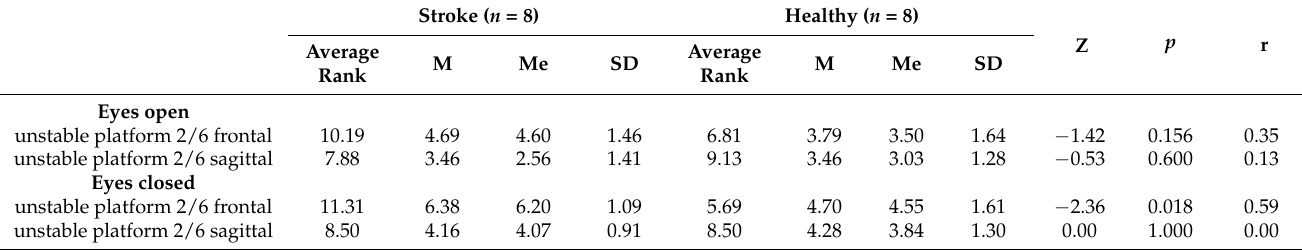
Table 4. Comparison of stroke patients and healthy patients in terms of the parameters